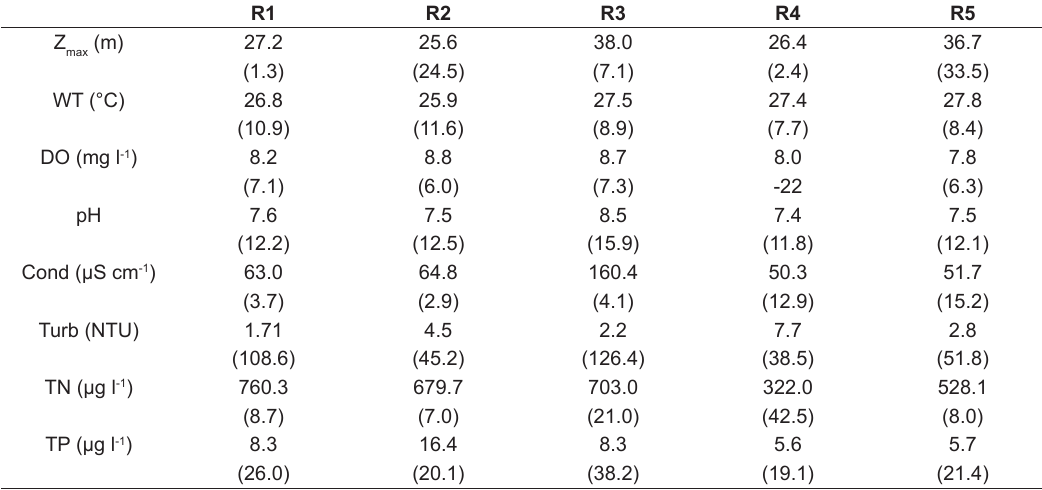
Table 2. Mean values and coefficients of variation – in % (in brackets) of the abiotic variables during the period between November 2013 and November 2014 in the reservoirs.